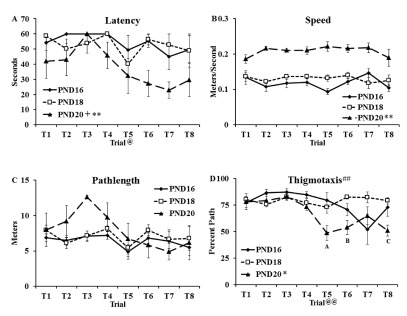
One-day Morris water maze task (MWM).Groups of rats were trained for one day (PND16, PND18, PND20) to locate the hidden platform on the water maze task. Swimming behaviors were captured with HVS Image software (version 1/09) and included: (
A) Latency in seconds (mean ± SEM) to reach the platform (60 s cutoff); (
B) speed in meters/second (mean ± SEM); (
C) pathlength in meters (mean ± SEM); (
D) thigmotaxis defined as percent of total pathlength spent within 10 centimeter of the pool wall (mean ± SEM). Significant group differences were found on latency to reach the platform with PND20 group showing shorter latencies than the PND16 (** p < 0.01) and PND18 (+, p < 0.05). Analysis of speed data revealed faster swim speeds in the PND20 group than both other age groups (**, p < 0.01). Measures of thigmotaxis revealed less thigmotaxis in the PND20 group than both other groups (*, p < 0.05). A significant interaction (##, p < 0.01) was also found and specific comparisons showed that the PND20 group spent less time along the edge of the pool on Trials 5 and 8 than PND16 and PND18 (
A and
C; p < 0.05) and on Trial 6 than PND18 (
B; p < 0.01). @ and @@ in
A and
D, respectively, refer to a main effect of Trial.